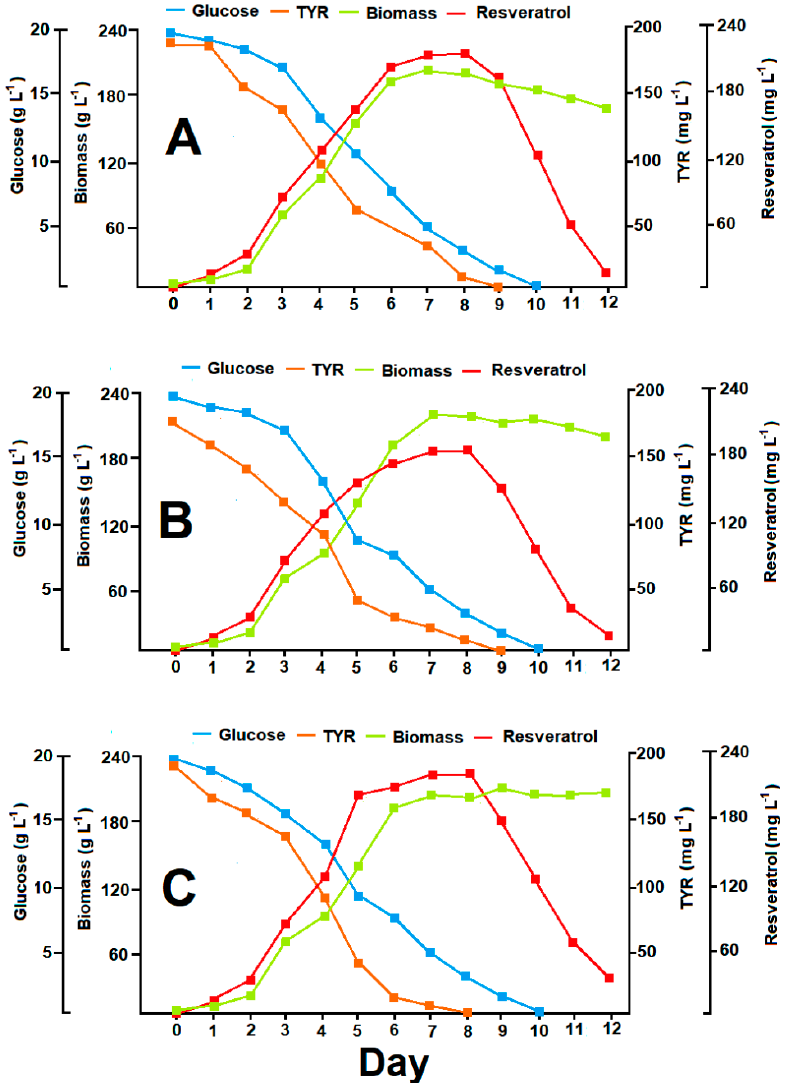
Figure 7. Kinetics of optimized batch cultures of A. aureus MaC7A. ( A ) Batch cultures containing 50 mg L − 1 citral. ( B ) Batch cultures containing 50 mg L − 1 thymol. ( C ) Batch cultures containing 100 mg L − 1 Glucanex. Each point from the kinetics was assayed ten times (n = 10). The content of glucose was depleted at day 10, whereas the maximum